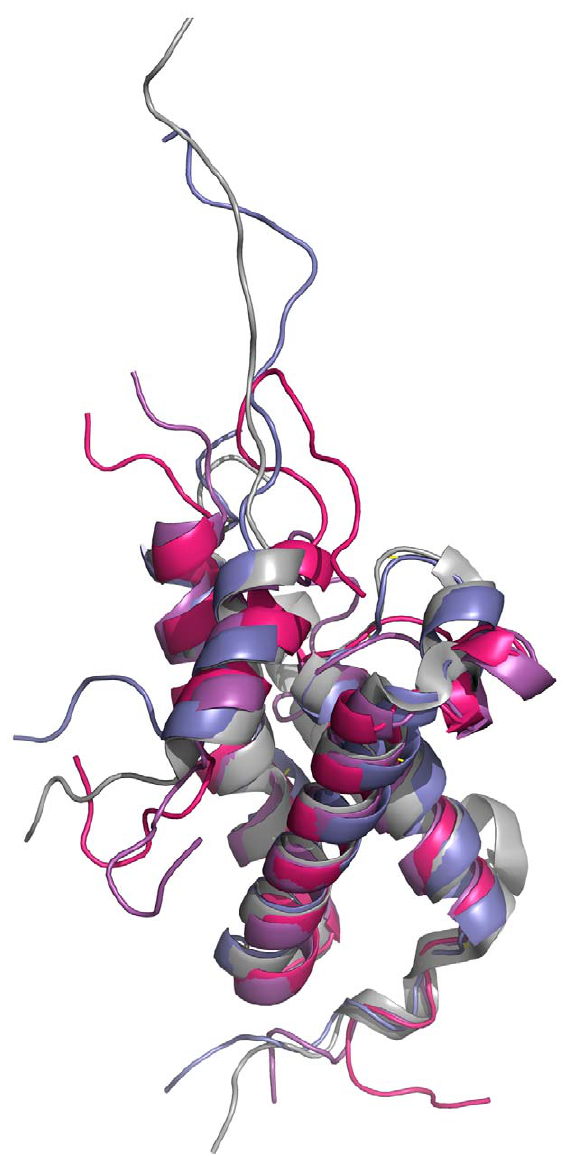
Figure 6. The loop behavior in Glu626Ala and of Leu628Ala mutants. Alignment of the average KIX structure from the simulations of Glu626Ala mutant of KIX:MLL complex (pink), Leu628Ala mutant of KIX:MLL complex (purple) and KIX:MLL structure from the NMR structure (grey) (PDB ID: 2AGH [11]) onto the average structure obtained by the KIX:MLL wild type simulation (blue) shown